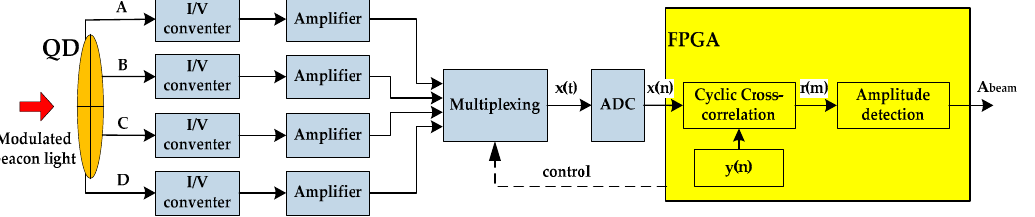
Figure 4. Schematic circuit diagram of digital processing.